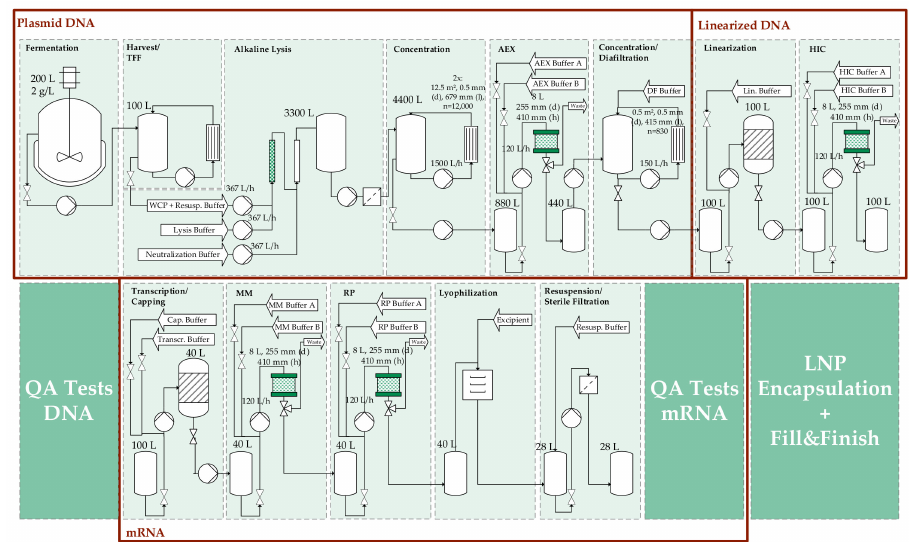
Figure 3. Detailed flowsheet for the production of mRNA. Starting with the generation and purifica- tion of the template DNA, followed by the in vitro transcription and purification of the mRNA, and ending with the encapsulation in lipid nanoparticles. Adapted from Schmidt et al. [2,4,5].